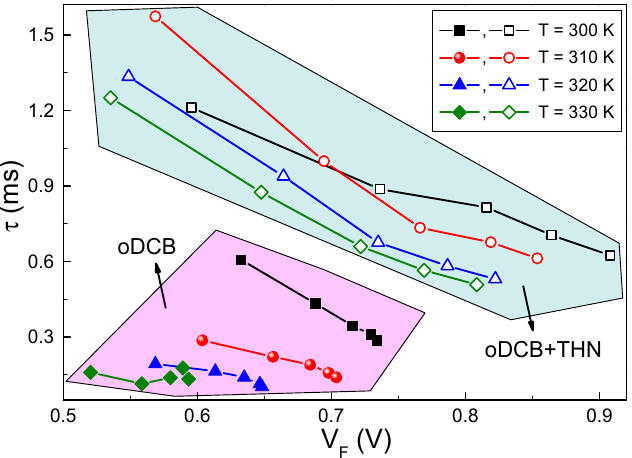
Figure 4. Effective carrier lifetime dependence on the forward voltage, at temperatures between 300 and 330 K. The experimental data are directly extracted by noise measurements. Full symbols refer to the oDCB solvent (pink region), while open symbols refer to the oDCB+THN solvent (blue region).